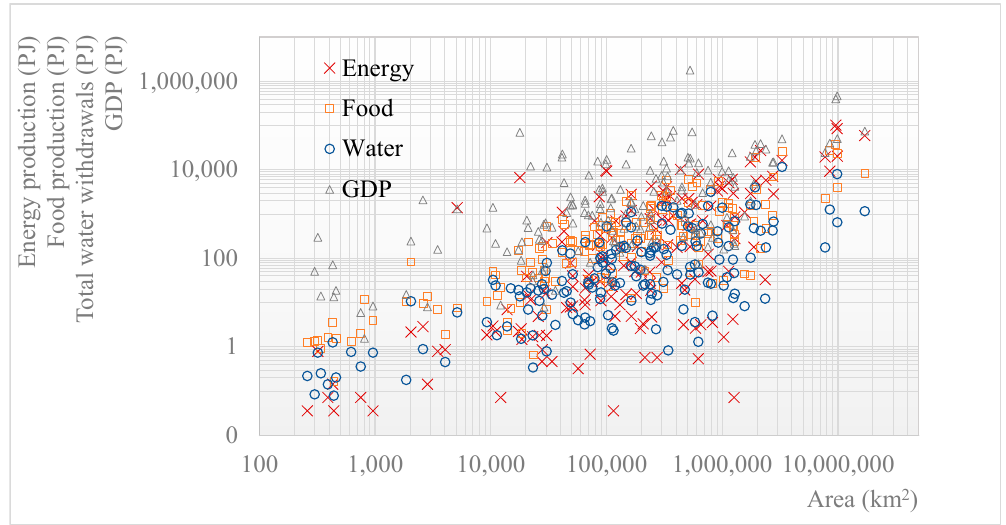
Figure 9. Primary energy production, food production, total water withdrawals, and GDP, vs. the area of each country (2019).